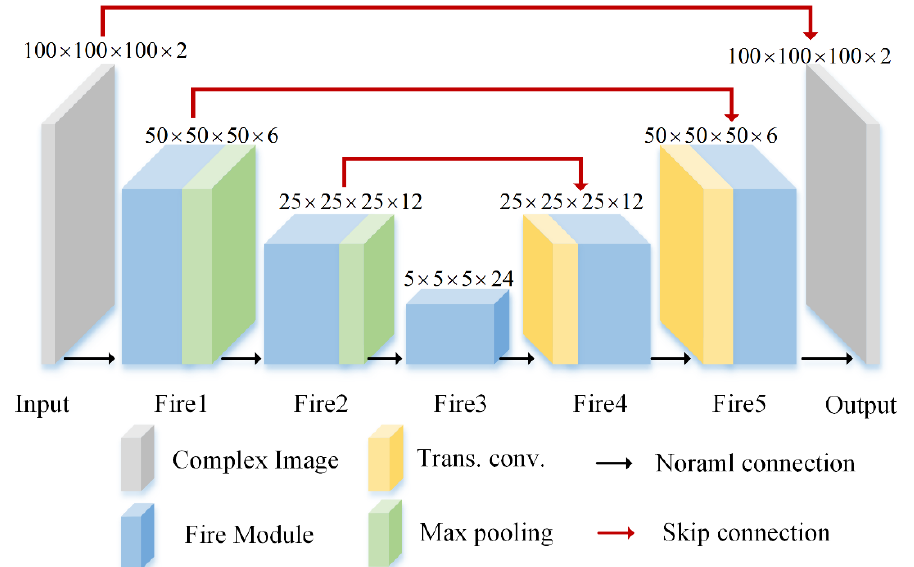
Figure 3. The whole network structure of SR-CNN.